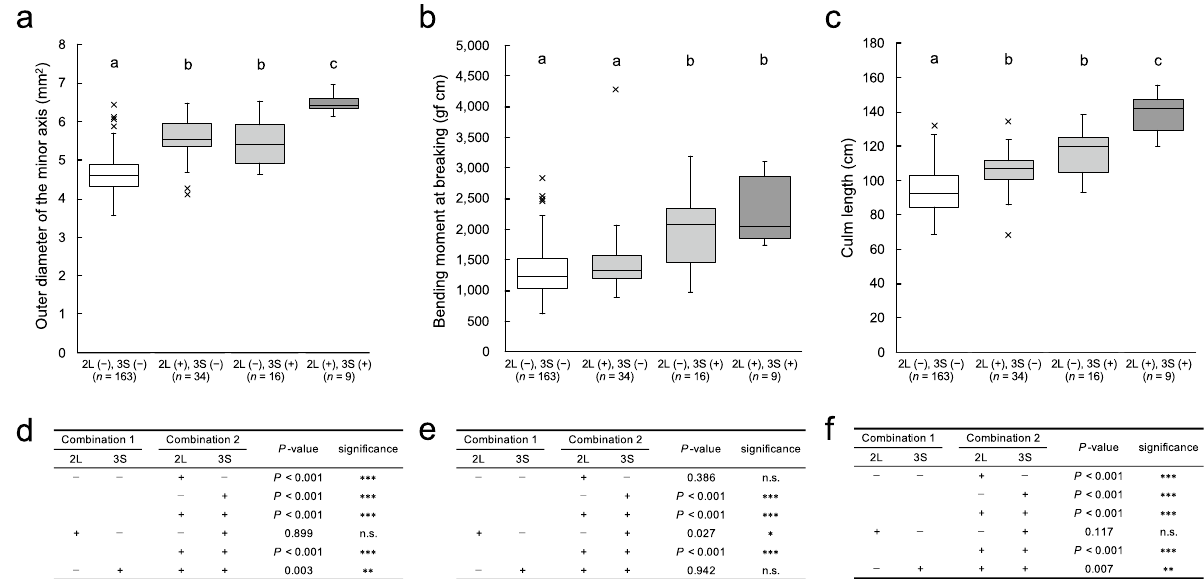
Figure 6. Combined effects of QTLs for lodging resistance-associated traits. Box plots of the trait values by the genotypes classified at the peak marker position in 2019: ( a ) ODMI; ( b ) BM; ( c ) culm length. Test results: ( d ) ODMI; ( e ) BM; f culm length. “2L” and “3S” mean the peak positions on chrs. 2L and 3S, respectively. “(−)” and “(+)” indicate the reference and alternative genotypes, respectively (based on the Nipponbare genome). The white, grey and black boxplots indicate the genotype combinations where both are references, one is a reference and the other is an alternative, and both alternatives, respectively. In the boxplots, different letters indicate significant differences at P < 0.05 (Steel–Dwass’s test). In the table, n.s. indicates no significant difference. *, **, *** indicate significant differences at P < 0.05, 0.01 and 0.001, respectively (Steel–Dwass’s test). Steel–Dwass test was performed using the package ‘NSM3’ for R software (https:// www.R- proje ct. org/) 65